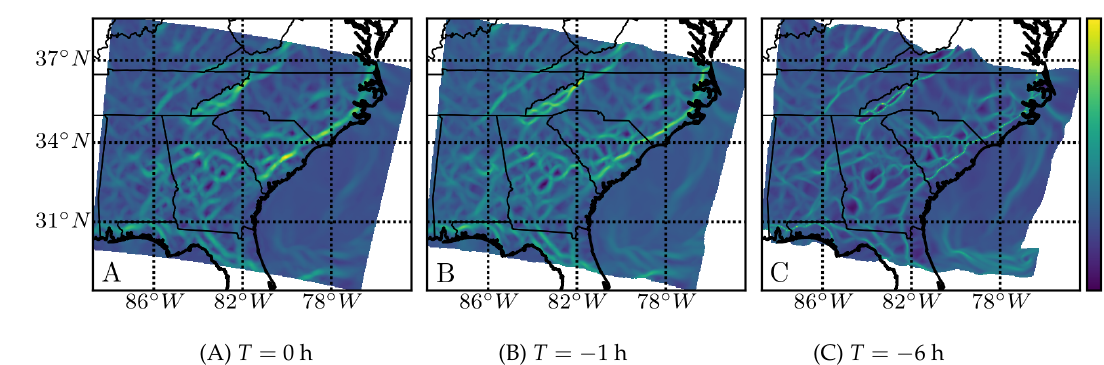
Figure 2. Backward-time FTLE field (relative scale shown in color bar) for the horizontal wind on a pressure layer at approximately 100 m AGL with integration times T of: ( A ) 0 h, ( B ) 6 h. See the video version at https://youtu.be/tUZwRAPXAWY. −